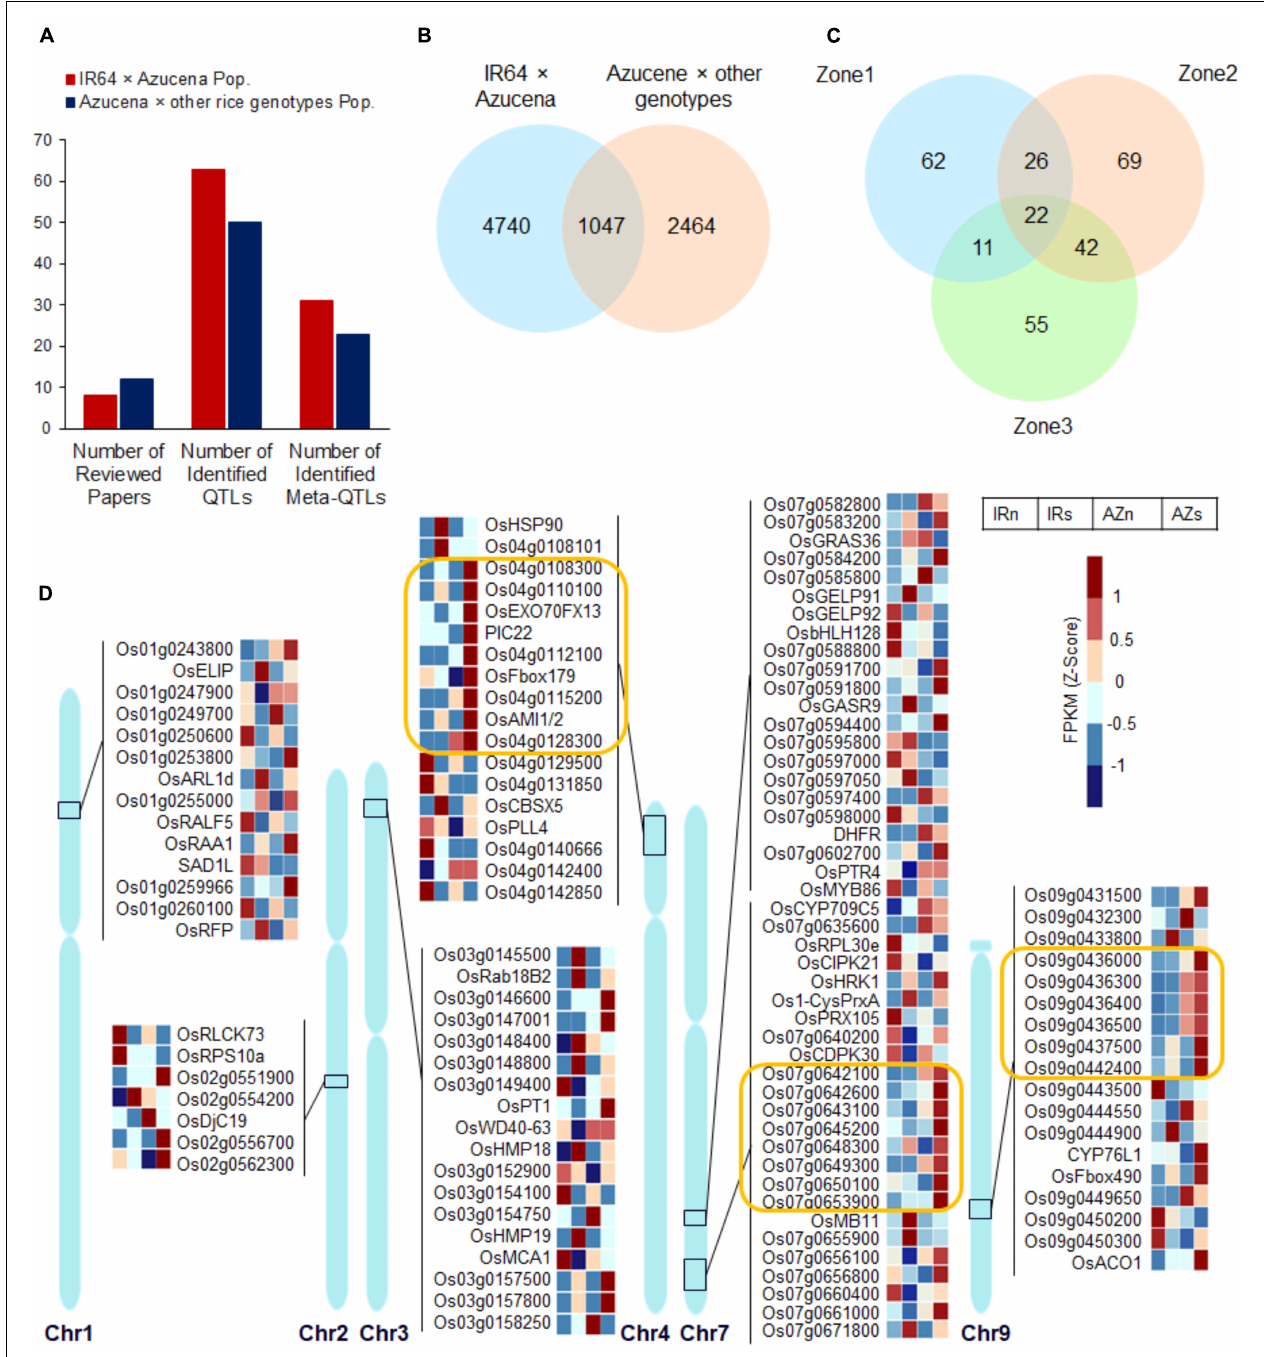
FIGURE 8 | The expression patterns of the genes extracted from integrating transcriptome profiling and Meta-QTL analysis which had significant interactions between genotypes and conditions. (A) Barplot showing the number of reviewed articles, collected QTLs, and the identified Meta-QTLs across the populations. (B) Venn diagram for extracted genes belonged to Meta-QTLs identified across the populations and their overlaps. (C) Venn diagram showing the number of genes with significant interactions (with a p -value cutoff of < 0.05) between genotypes and conditions (a two-way ANOVA was performed on 1047 genes detected from the overlapping of the populations) in three zones and their overlaps. (D) The expression pattern of the DEGs belonged to Z1, on their chromosomal regions; three subsets of genes on chromosomes 4, 7, and 9 showing co-upregulation in response to water stress in Azucena were surrounded by orange lines. IRnZ1, root Z1 of IR64 under normal condition; IRsZ1, root Z1 of IR64 under stress condition; AZnZ1, root Z1 of Azucena under normal condition; AZsZ1, root Z1 of Azucena under stress